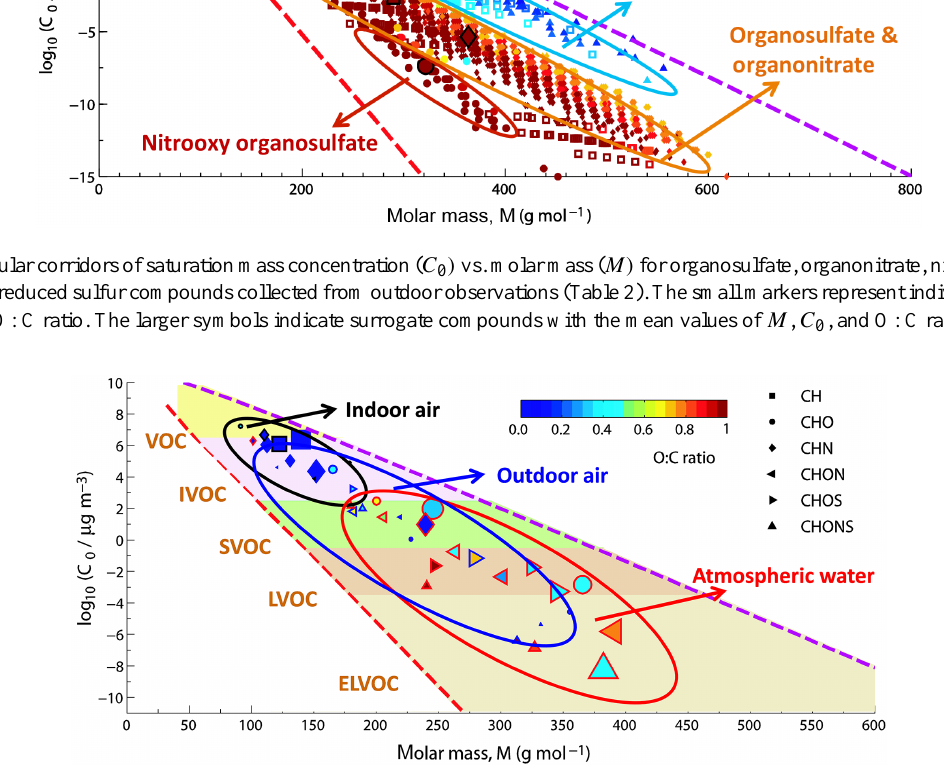
Figure 9. Average molecular corridors for OA observed in indoor air, outdoor air, and atmospheric water. The markers show surrogate compounds with the mean values of molar mass ( M) , saturation mass concentration ( C 0 ) , and O : C ratio computed from every observation event (Figs. 5–7). The edge color of the symbols indicates the surrogate compound identified in indoor air (black), outdoor air (blue), and atmospheric water (red). The symbol size is scaled by the ratio of the number of compounds in each class (e.g., CH, CHO, CHON, CHONS) to the total number of compounds in each data